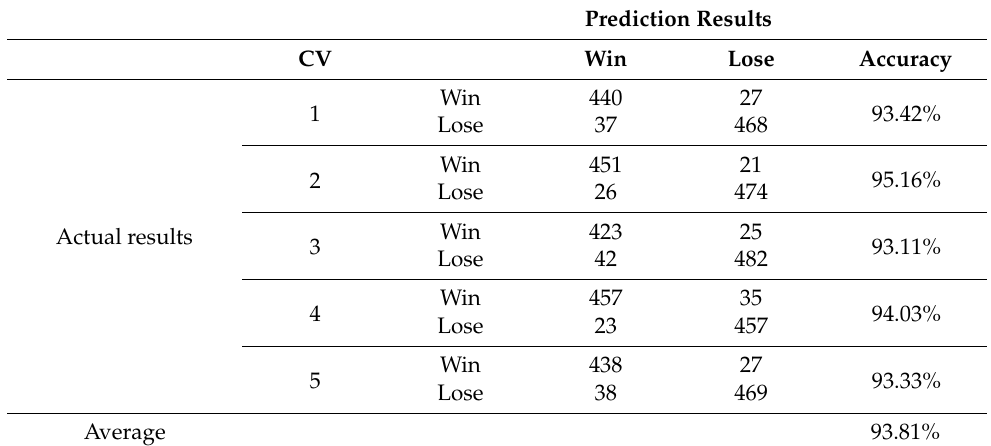
Table 13. Confusion matrix of SVM without feature selection (dataset